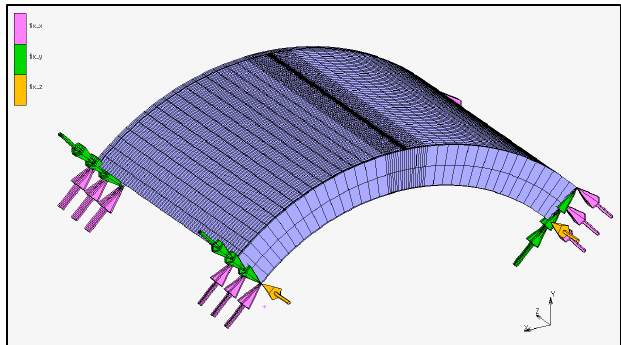
Figure 4. Boundary condition for seam welding [27].